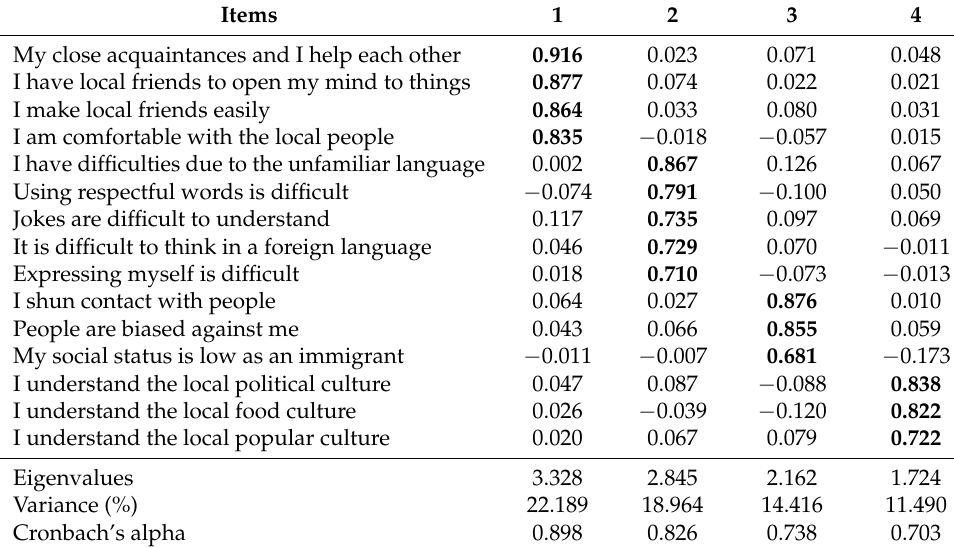
Table 3. Factor structure matrix for social adjustment.